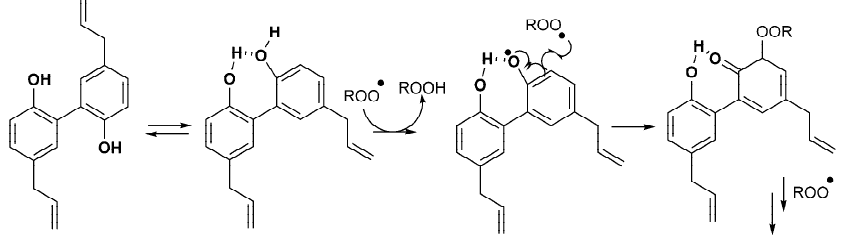
Figure 10. Radical scavenging activity of magnolol